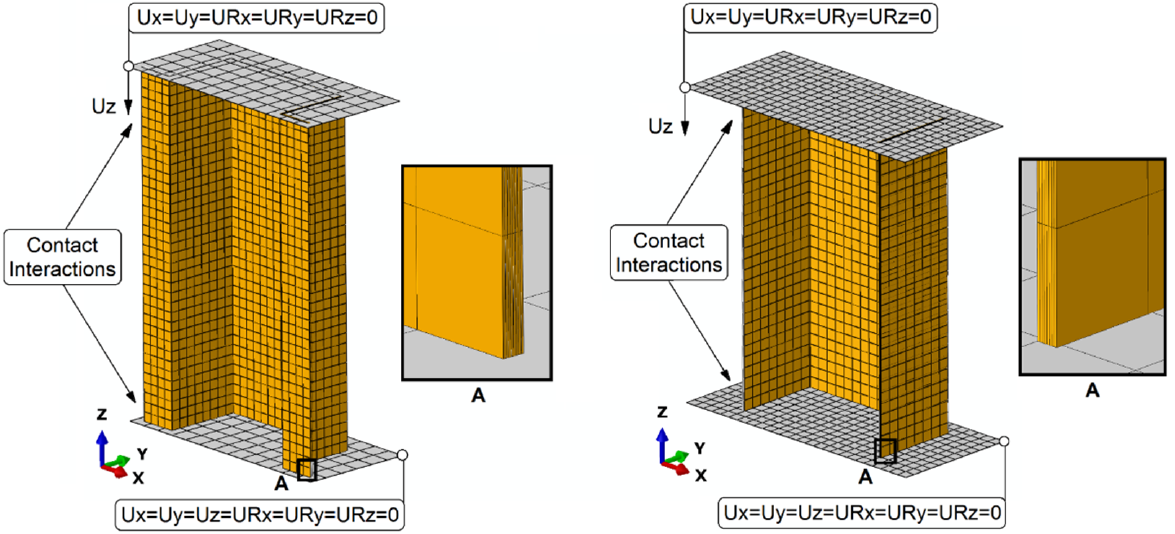
Figure 3. Discrete models with boundary conditions.